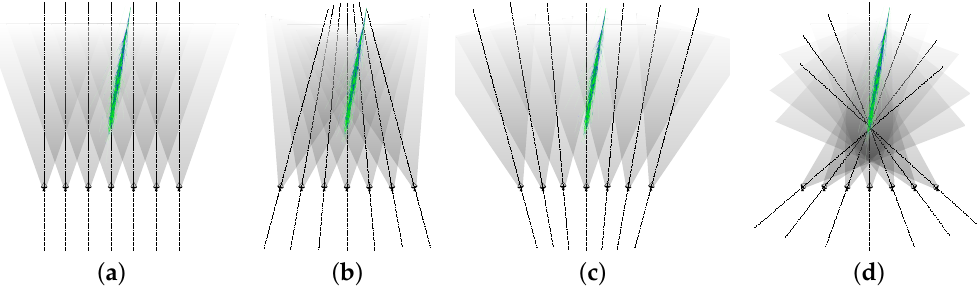
Figure 2. From left to right : ( a ) parallel pointing, ( b ) convergent pointing at high altitude, ( c ) divergent pointing, ( d ) con- vergent pointing at low altitude, also denoted skewed pointing.